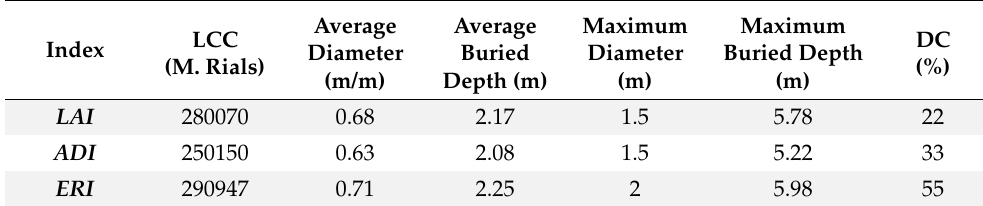
Table 2. Design parameters of simple cost index-optimized urban drainage system (UDS) designs.